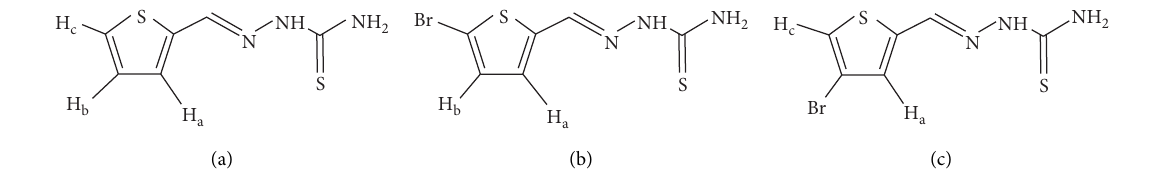
Figure 1: Ligands (a) L1, (b) L2, and (c)